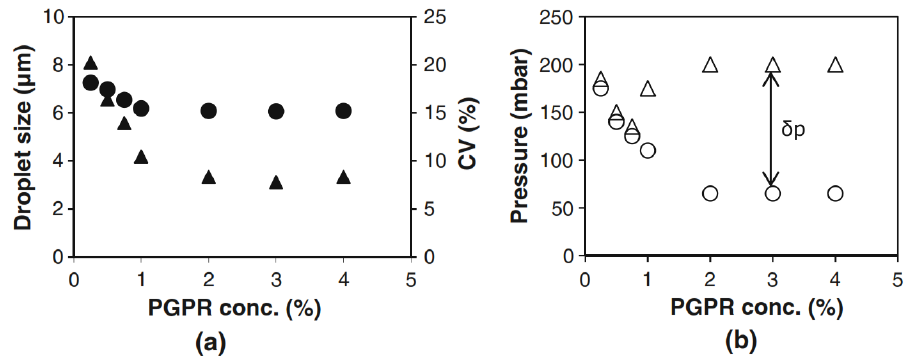
Figure 4. Droplet size (filled circles) and coefficient of variation (filled triangles) as function of the PGPR concentration used ( a ); Minimal pressure for droplet formation (open circles); and blow-up pressure (open triangles as function of PGPR concentration ( b ) [44].